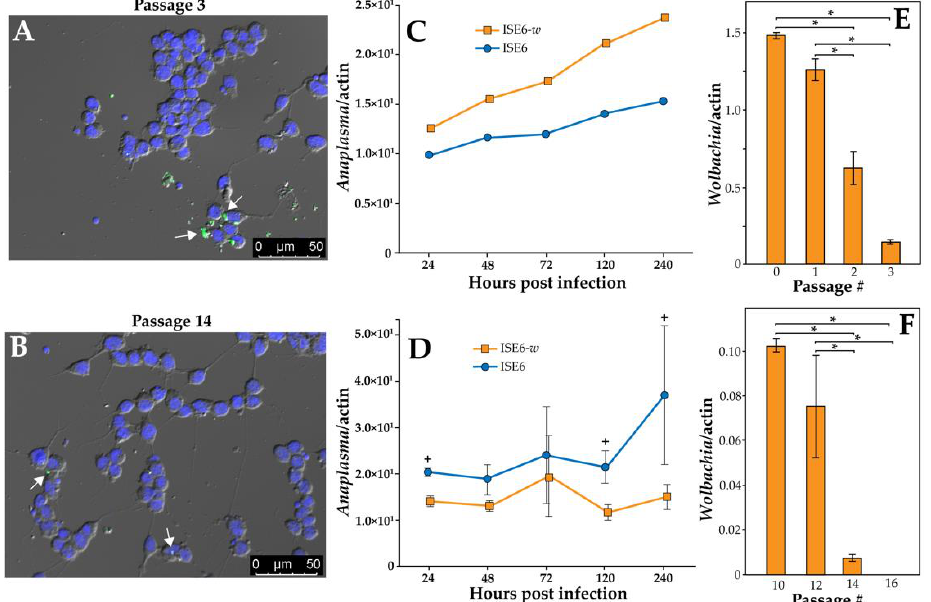
Figure 1. ( A ) Fluorescent in situ hybridization (FISH) staining of ISE6- w cells confirming Wolbachia infection establishment at passage 3 post transfection, ( B ) FISH staining of ISE6- w cells at passage 14, ( C ) A. phagocytophilum copy number normalized to the actin gene in ISE6- w and ISE6 cells at passage 3, ( D ) A. phagocytophilum copy number normalized to the actin gene in ISE6- w and ISE6 cells at passage 14. The + above data points represent significant differences according to pairwise Wilcoxon rank sum tests ( p ≤ 0.05), ( E ) Wolbachia copy number in ISE6- w cells normalized to the actin gene for passages 0–3 post transfection of Wolbachia , and ( F ) Wolbachia copy number in ISE6- w cells normalized to the actin gene for passages 10–16. The * above the bars represent significant differences according to Bonferroni corrected t -tests ( p ≤ 0.008). All data are represented as mean ± standard error.